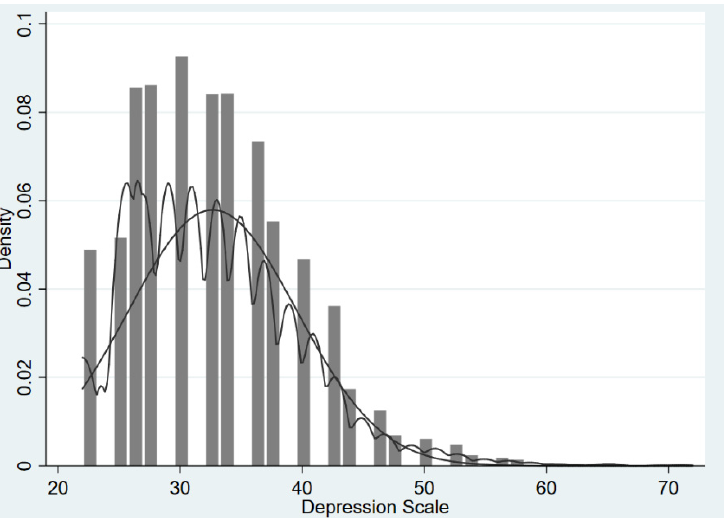
Figure 1. Histogram for depression scale distribution, overlaid with a kernel density and a normal density.